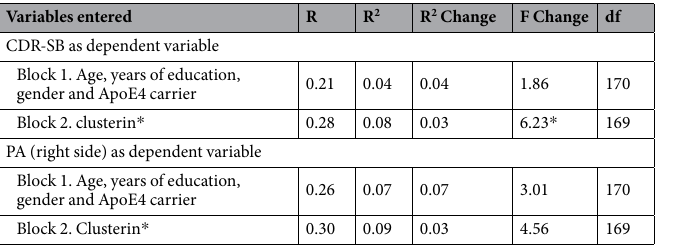
Table 5. Summary of regression analyses for clusterin level predicting the CDR-SB and PA (right side) in patients with AD. Aß, amyloid ß peptide; AD, Alzheimer’s dementia; MTA, medial temporal atrophy visual rating score; PA: posterior atrophy visual rating score; ApoE, apolipoprotein E. * p <